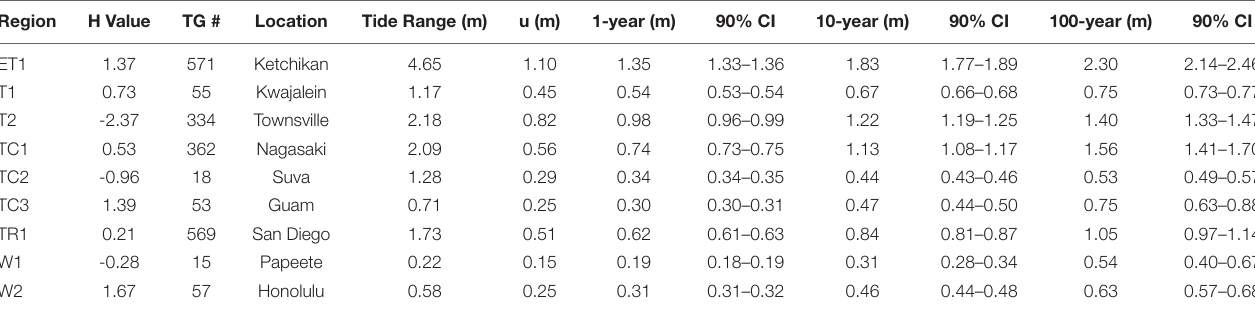
TABLE 1 | An example of 1-, 10-, and 100-year return levels (meters above MHHW) with 90% confidence intervals (CI: spread of the 5th and 95th% levels) from regional frequency analysis (RFA) highlighting a subset of tide gauges (TG) within each homogeneous region and its H value. Region H